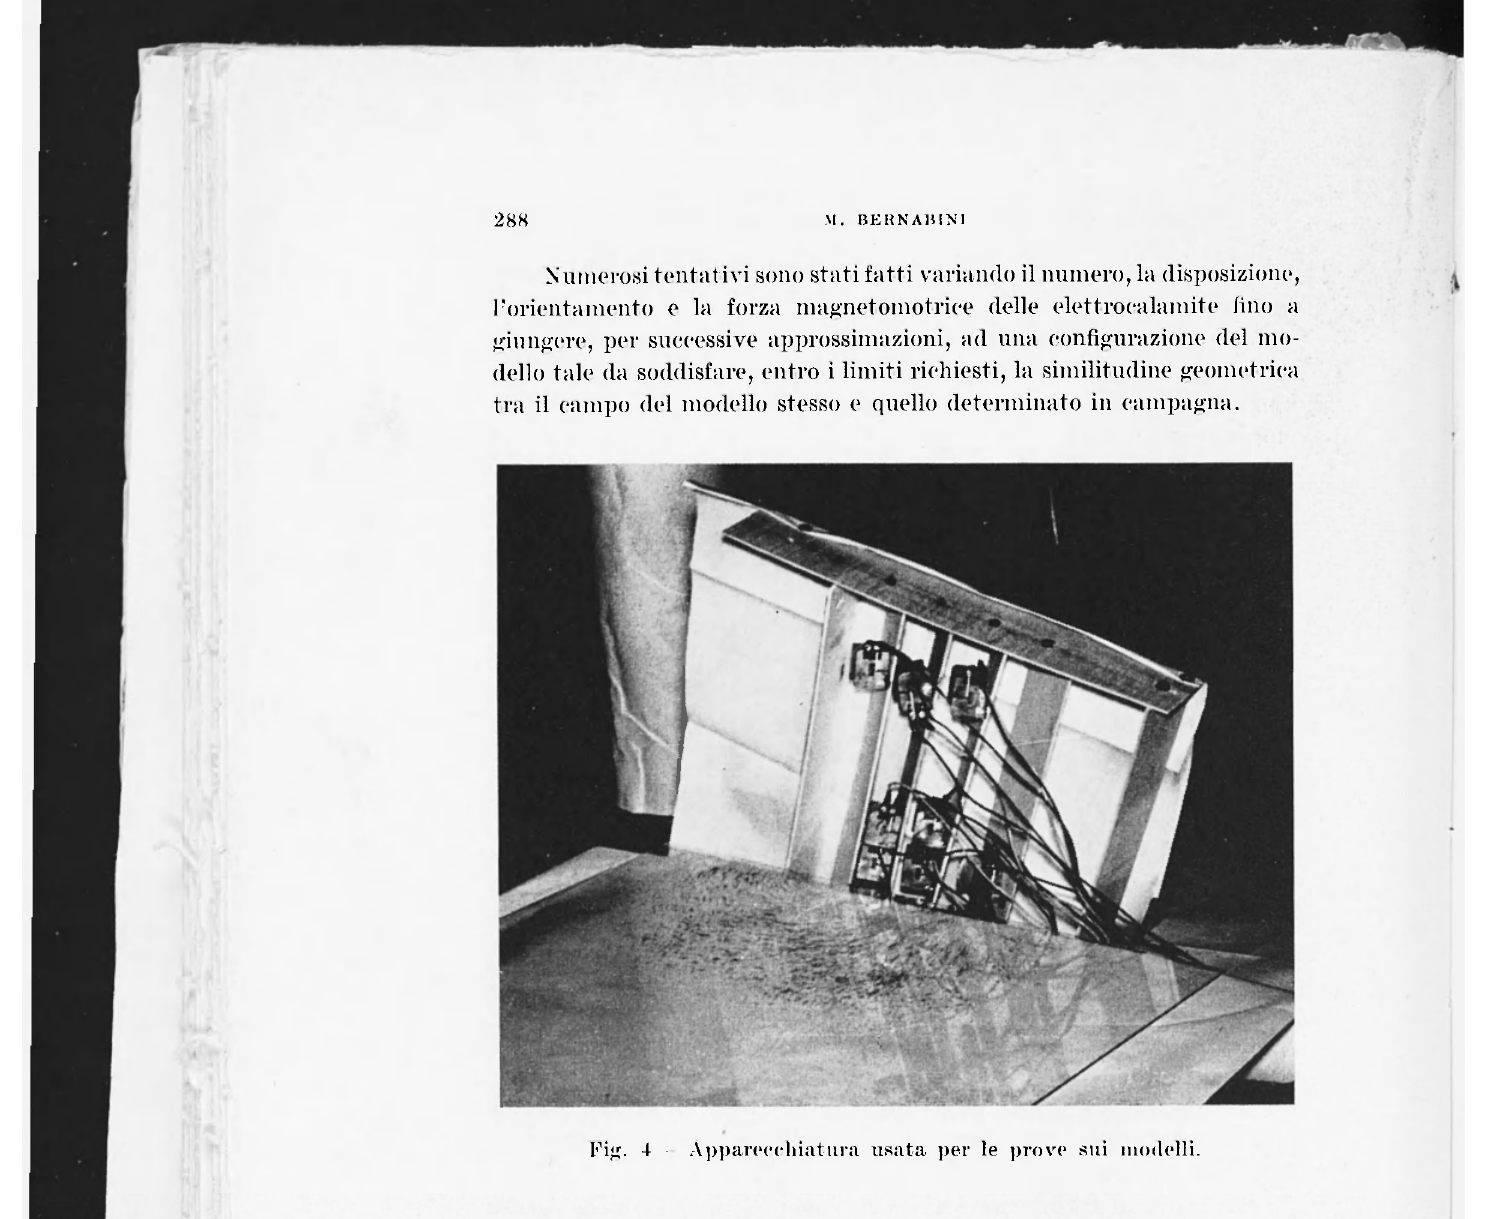
Fig. 4 Apparecchiatura usata per le prove sui